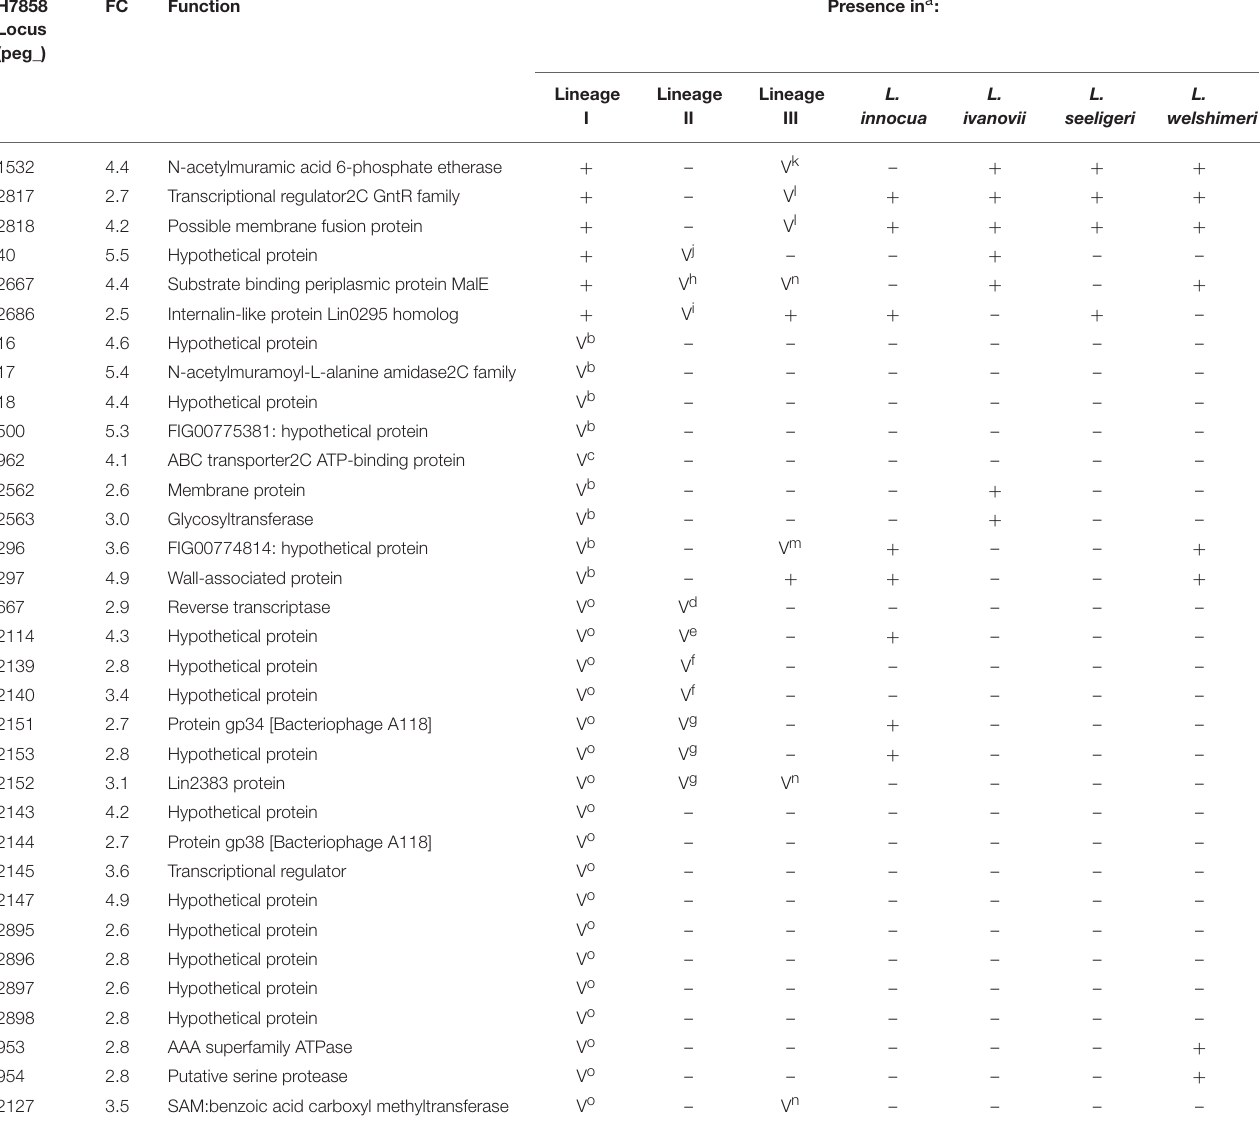
TABLE 3 | Genes upregulated by bile in H7858 with no homolog in 10403S. H7858